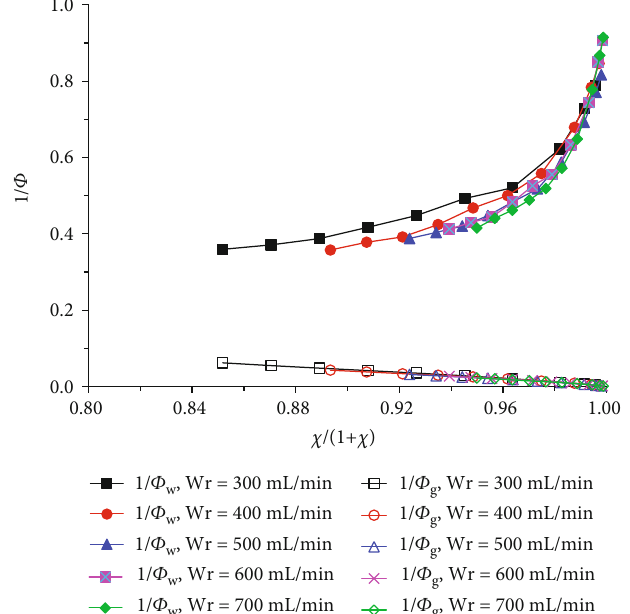
Figure 11: The relationship between Φ